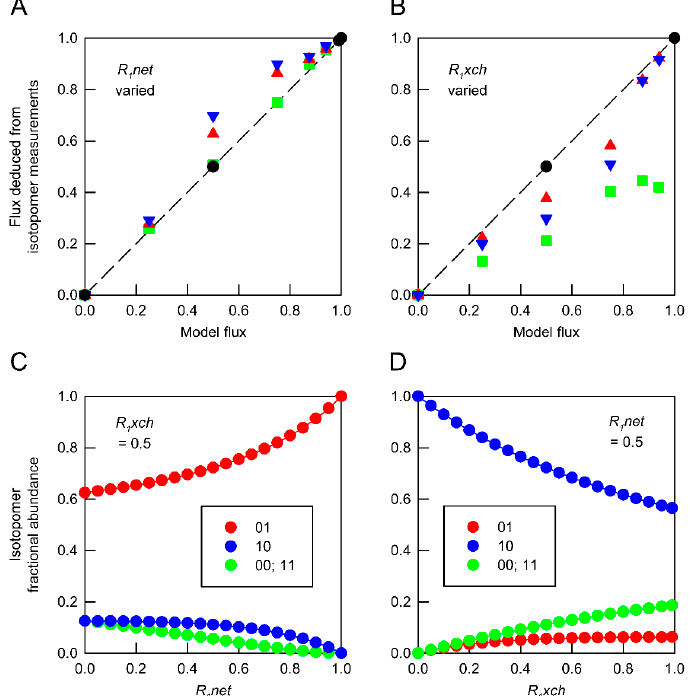
Figure 2. Reliability of flux estimates in a network containing two variable fluxes. The basic model described in Figure 1 was modified by making R 1 reversible. Flux through this network is defined by a single net flux ( R 1 net ) and a single exchange flux ( R 1 xch ). Simulated isotopomer measurements for metabolites ( A – C ) were obtained for networks in which both of these fluxes were varied independently. Fluxes deduced from individual isotopomer datasets and from weighted average datasets generated by combining values obtained from different networks were compared with the anticipated model flux determined by the relative contributions of the different networks to the isotopomer dataset. ( A ) Deduced values of R 1 net from combinations of networks in which R 1 xch values were held at 0 ( ■ ), 0.5 ( ▲ ) and 0.99 ( ▼ ). ( B ) Deduced values of R 1 xch from combinations of networks in which R 1 net values were held at 0 ( ■ ), 0.5 ( ▲ ) and 1.0 ( ▼ ). In both panels, isotopomer datasets from individual networks yielded the expected flux values under all conditions ( ● ). Each deduced flux value is the mean of 100 Monte Carlo simulations for which the SD is smaller than the symbol. The dashed line indicates equivalence between deduced flux estimate and model flux. The influence of flux distribution on the isotopomer composition of metabolic intermediates is exemplified by changes in the composition of metabolite A in response to ( C ) varying R 1 net while R 1 xch is held at 0.5, and ( D ) varying R 1 net while R 1 xch is held at 0.5. Isotopomers are identified using 0 to indicate 12 C and 1 to indicate 13 C in specified positions. In these simulations, the fractional abundances of 00 and 11 are identical.